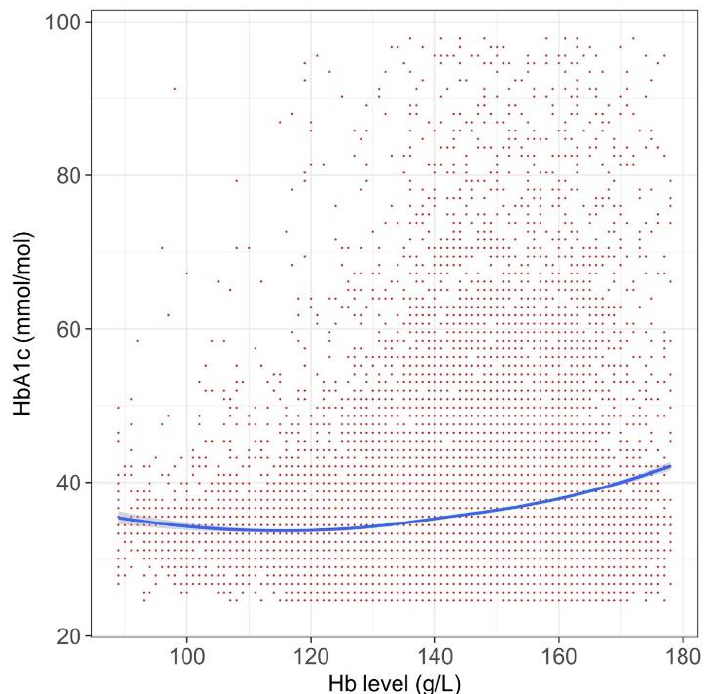
Figure 2. The relationship between Hb and hemoglobin A 1c (HbA 1c ) value for the whole cohort ( n = 55,420). Data are shown in a spline curve with a 95% confidence interval (gray zone). Dots represent the raw data of each person, with overlapping allowed. The range of axis was chosen in order to cover ~99% of the target population.